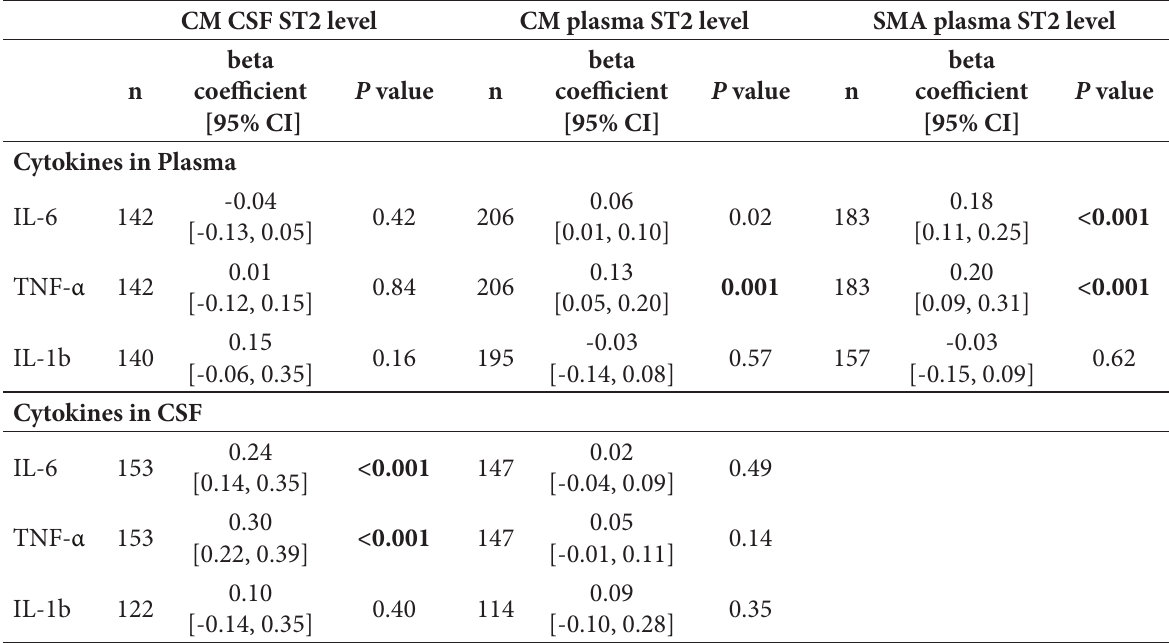
Table 2. Association between plasma and CSF levels of sST2 to plasma and CSF pro-inflam- matory cytokine